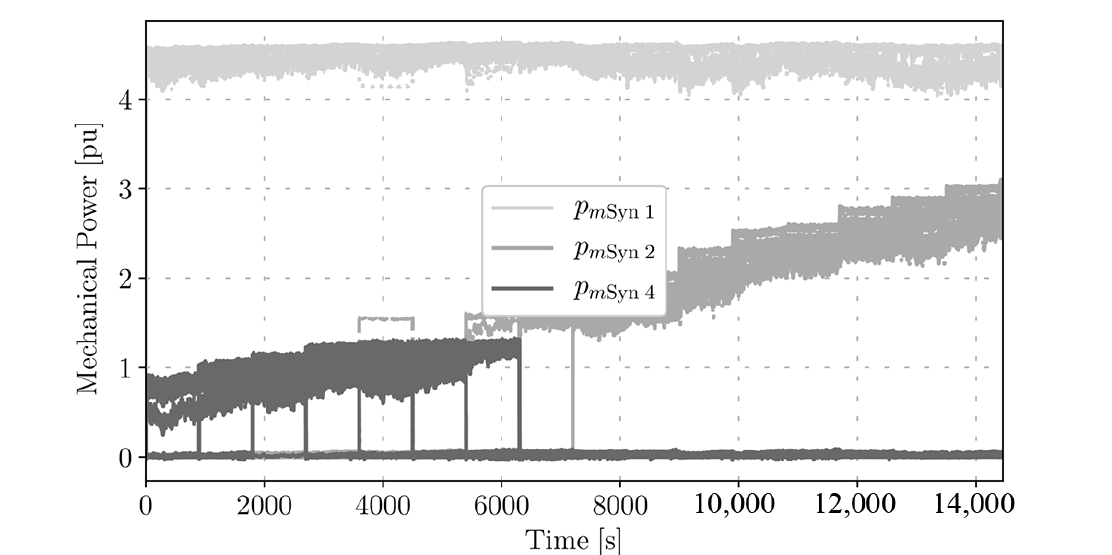
Figure 10. Mechanical power of synchronous generators 1, 2 and 4, for 15-min time period and simplified SUC